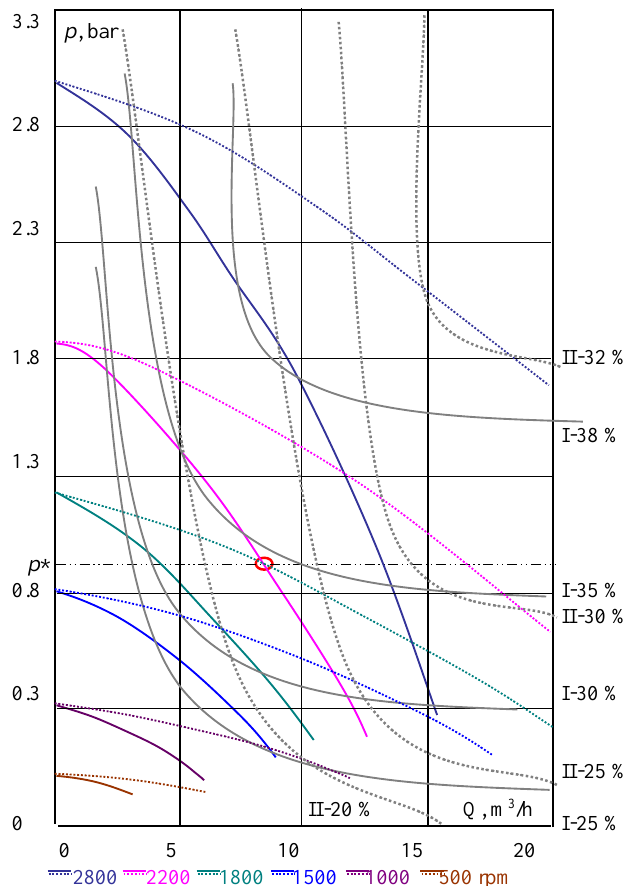
Fig. 3. A family of Qp -curves for the solo Ebara CDX 120/12 (solid lines) and the pair of parallel-connected pumps (dotted lines) driven by ACQ810 VSD with appropriate efficiency regions for the solo (I) and paired (II) pumps.